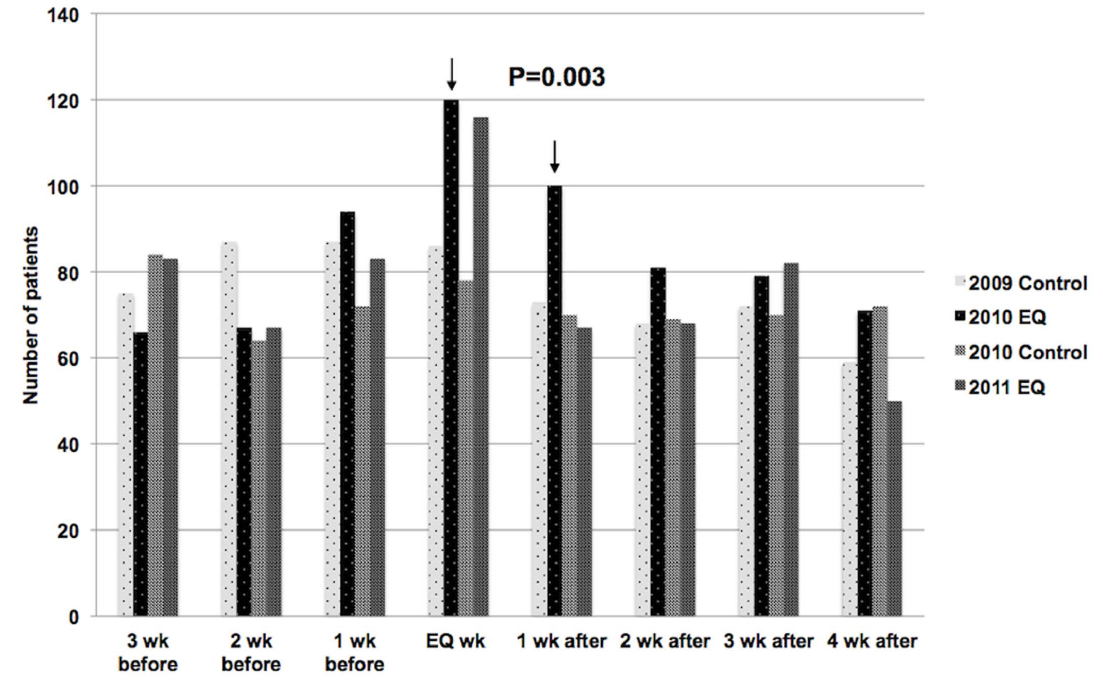
Figure 1. Total acute cardiology admissions.